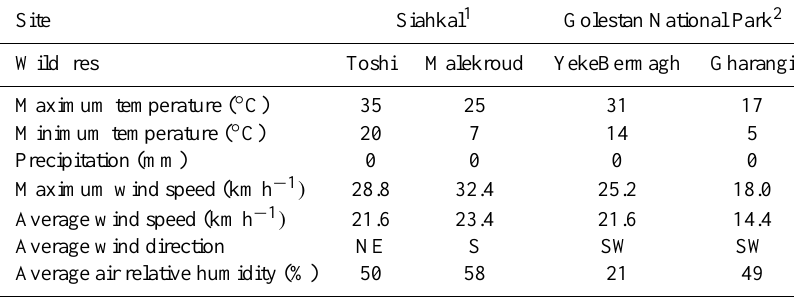
Table 2. Weather conditions observed during the wildfire days in the closest weather stations.